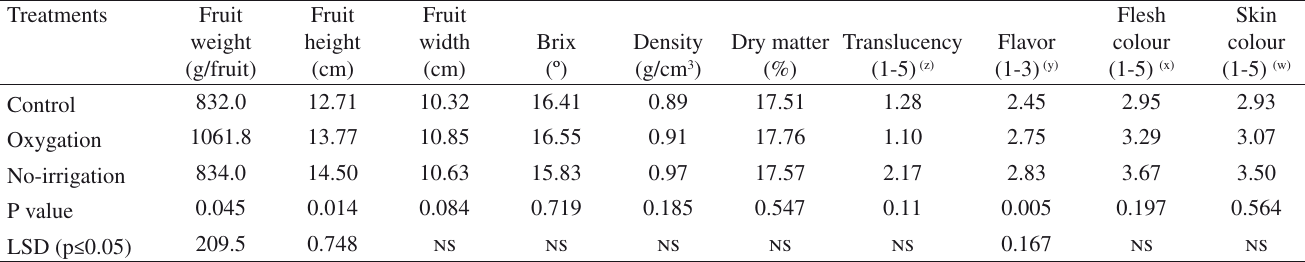
Table 9 - Fruit characteristics and quality parameters of pineapple as affected by irrigation treatments in the main crop